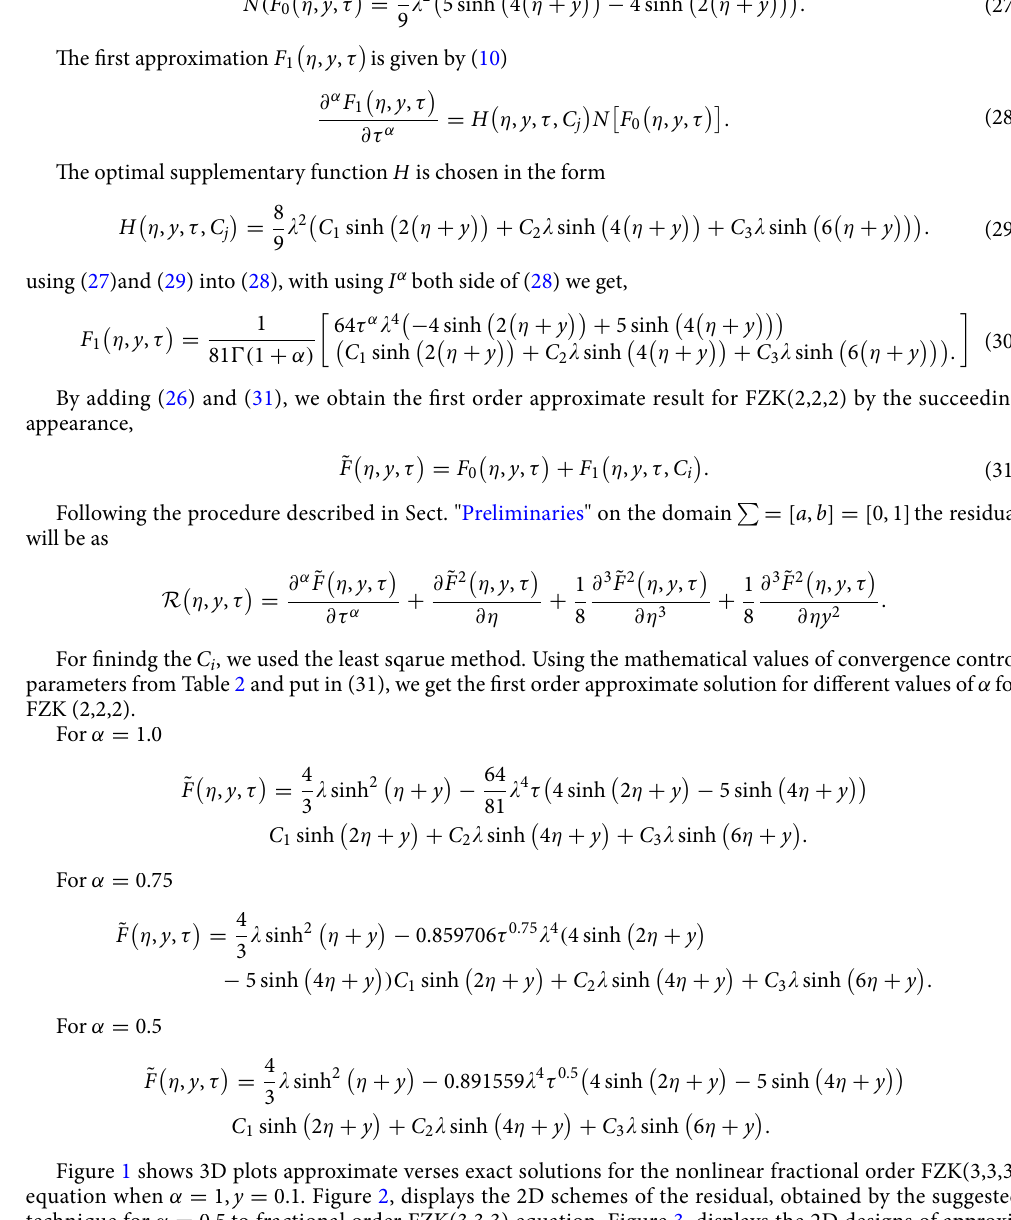
The first approximation F 1